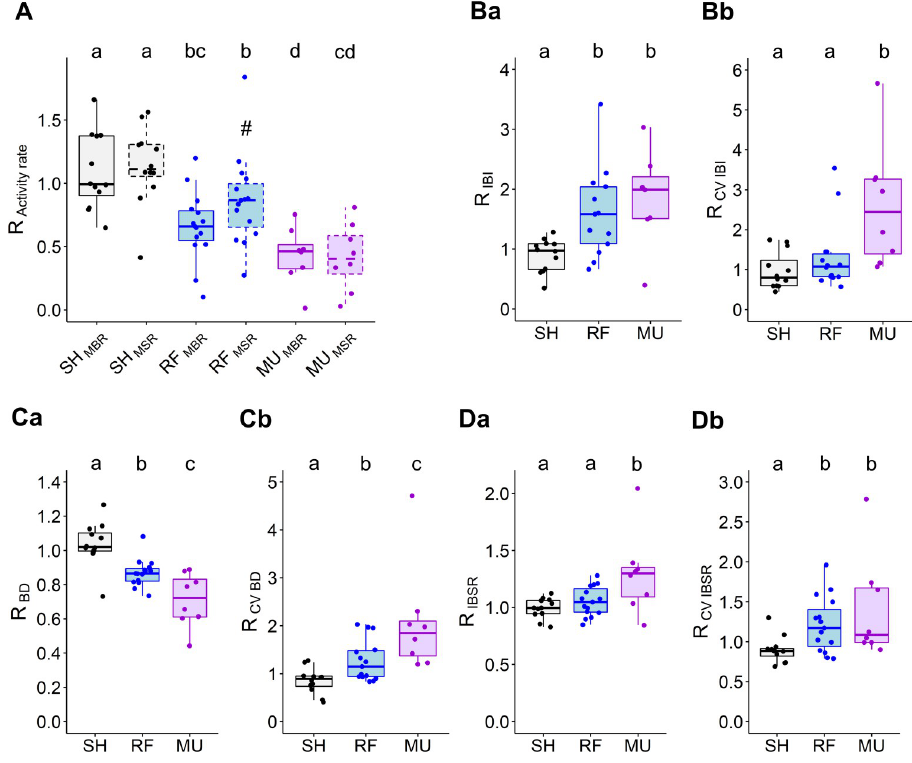
Fig 2. Comparison between RF and MU-induced inhibition of cultured cortical network. (A) Average effect of 15 min of exposure to RF and MU on MBR and MSR (spike outside burst periods). Boxplots with dashed box denote MSR data. (#) is indicative of p = 0.0535 against RF -MBR and RF -MSR . (Ba) Average effect of 15 min of exposure to RF and MU on mean inter-burst interval (IBI), (Ca) mean burst duration (BD), (Da) mean inter-burst spike rate (IBSR). (Bb, Cb and Db) Coefficients of variation (CV) respectively for IBI, BD and IBSR. Normalized data, ratio of the exposure phase to baseline. SH: n = 12; RF: n = 15; MU: n = 8. (A-Db). Lower case letters indicate significant differences between